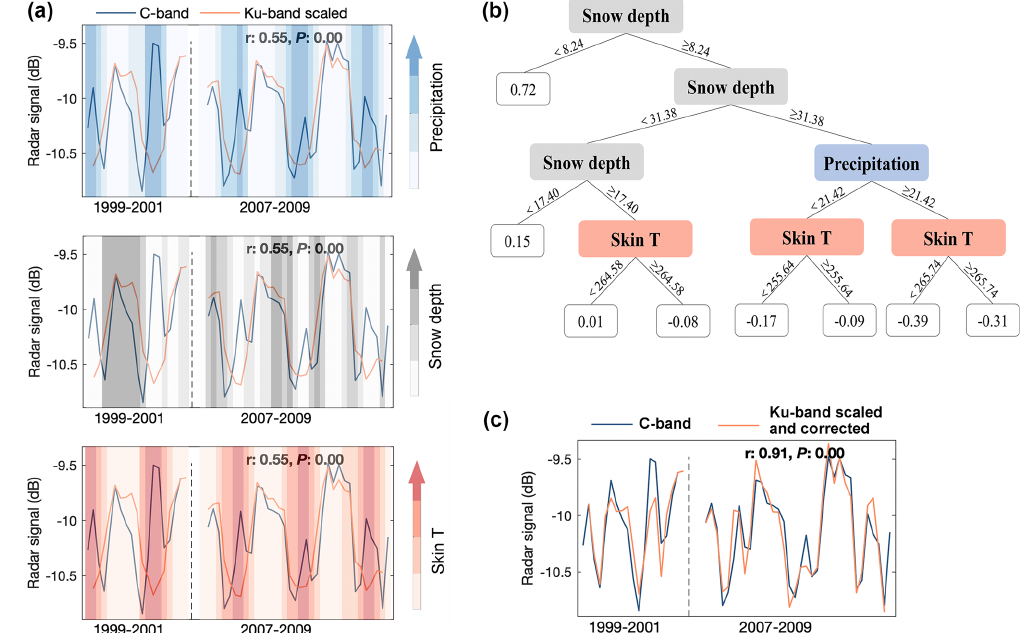
Figure 4. Illustration on the correction of the monthly signal differences between the C-band and the scaled Ku-band signals in the overlap- ping years (1999–2001 and 2007–2009), taking 1 pixel in the Tibetan Plateau (88.01 ◦ E, 33.73 ◦ N) as an example. (a) The C-band and the scaled Ku-band signals before correction. The three panels in (a) show the radar signals against monthly precipitation (mm), skin temperature (K), and snow depth (mm). The vertical dotted line in each panel separates the ERS-QSCAT overlapping period (1999–2001) and QSCAT- ASCAT (2007–2009) overlapping period. (b) Decision tree regression with monthly precipitation, skin temperature, and snow depths as predictors of the signal differences. (c) The C-band and the final corrected Ku-band signals by the decision tree